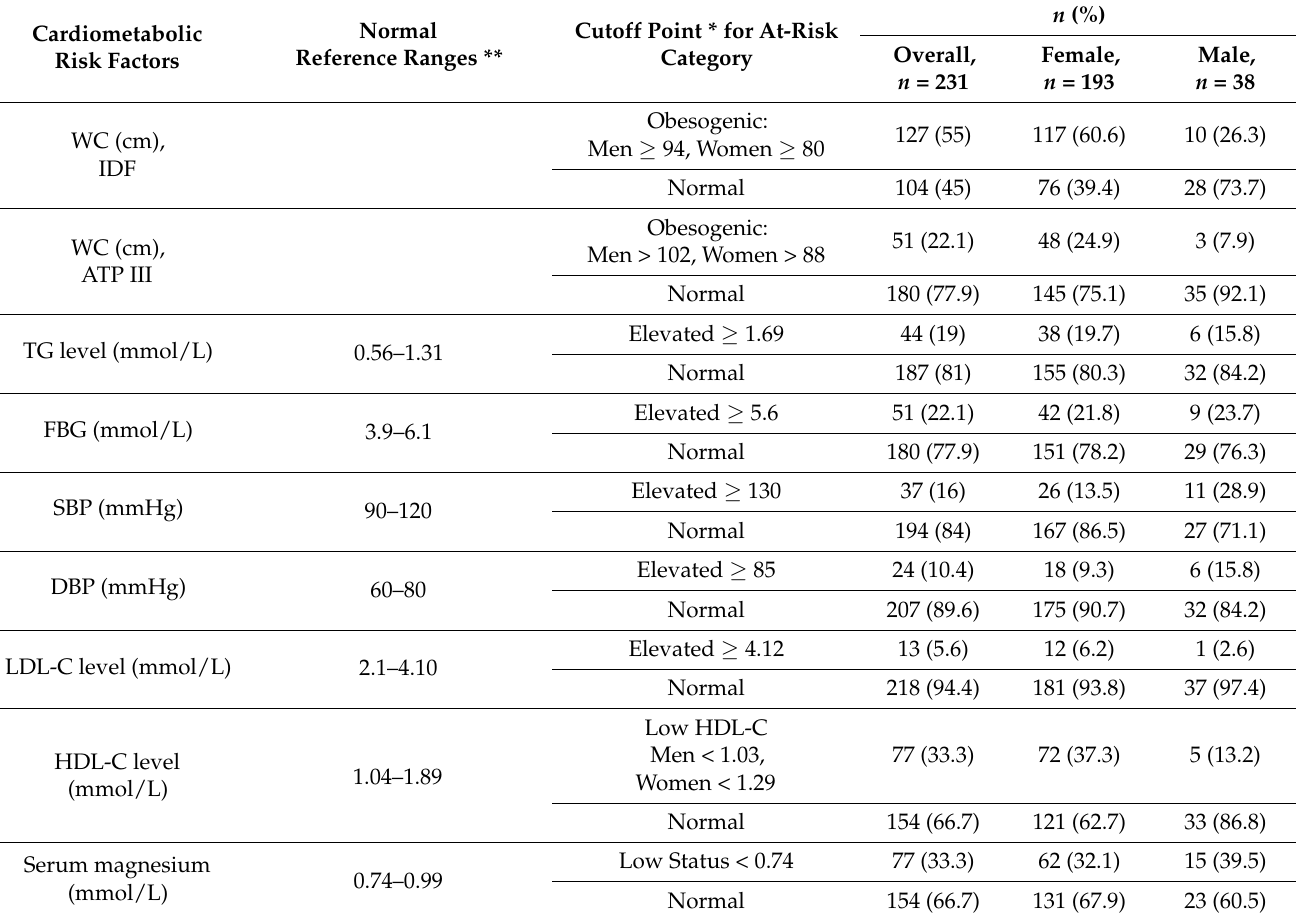
Table 3. Distribution of cardiometabolic risk factors in the overall sample population in terms of sex.